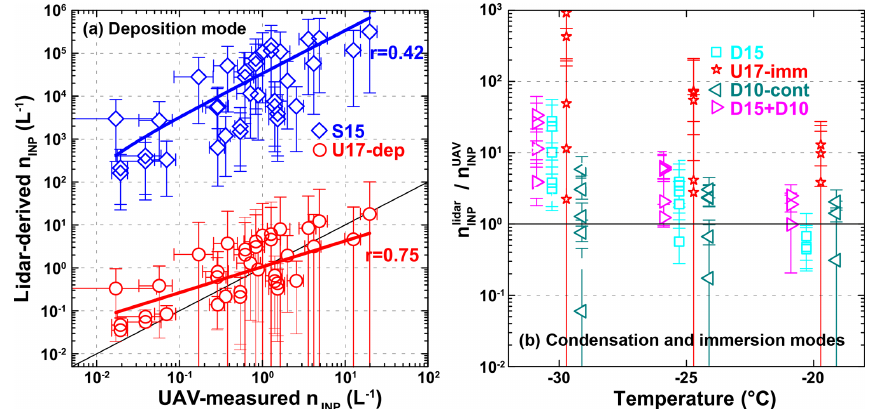
Figure 10. Comparison of INP concentrations derived from the CALIPSO and PollyXT lidar observations and UAV-FRIDGE measurements for (a) deposition freezing and (b) condensation and immersion freezing for cases with dust and continental presence. Colors and symbols refer to the used parameterization. Lines in (a) and (b) mark the 1 : 1 line. Numbers in (a) give the Pearson r of the linear